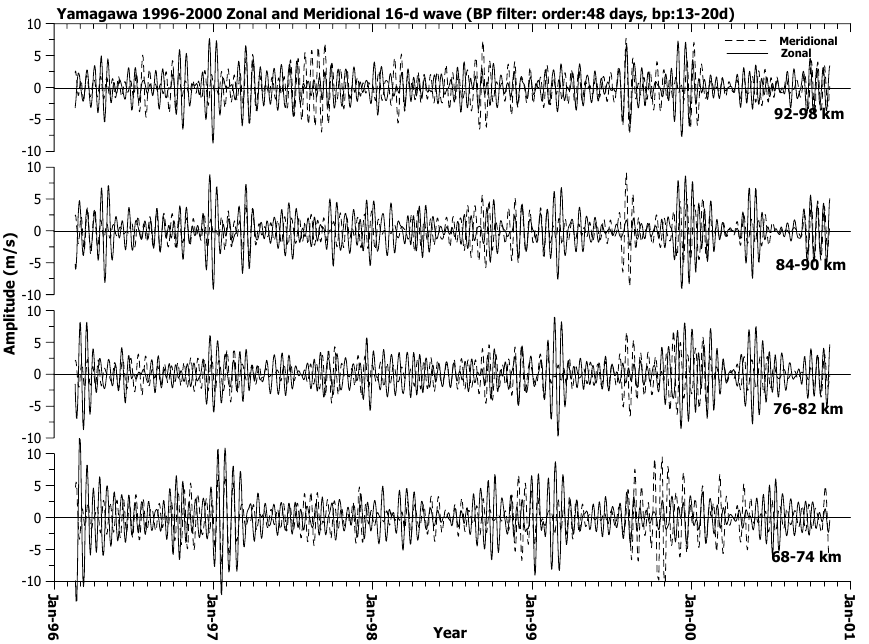
Fig. 2. The band-pass filtered 16-day oscillations at four altitude layers at Yamagawa during 1996–2000. The solid and dashed curves represent the zonal and meridional components,